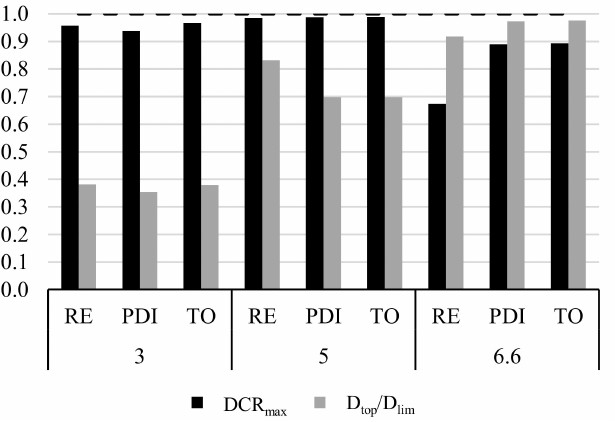
Figure 16. Performance assessment of the analysed patterns: DCR max , D top /D lim .